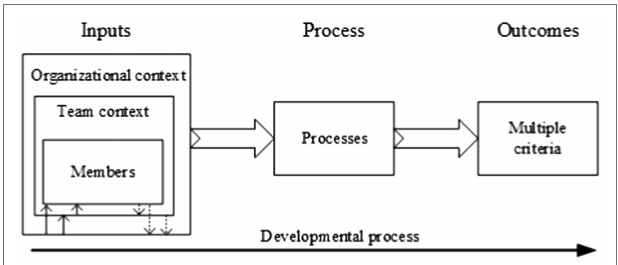
FIGURE 1 | The input-process-output model (Refers to Mathieu et al., 2008). Republished with permission of Sage Publication Inc. Journals from Mathieu et al. (2008); permission conveyed through Copyright Clearance Center,